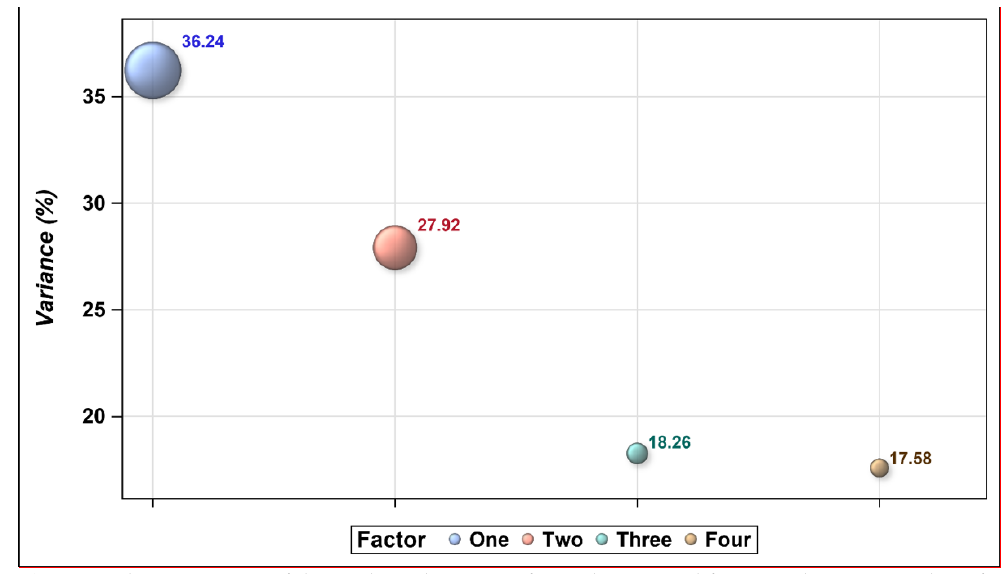
Figure 1. The percentage of the explained variance for each extracted factor with an eigenvalue of ≥ 1. Table 4. Multiple linear regression for the association of EMIC stigma score and different factors. 95% Confidence Interval (CI) Variables β -Estimates